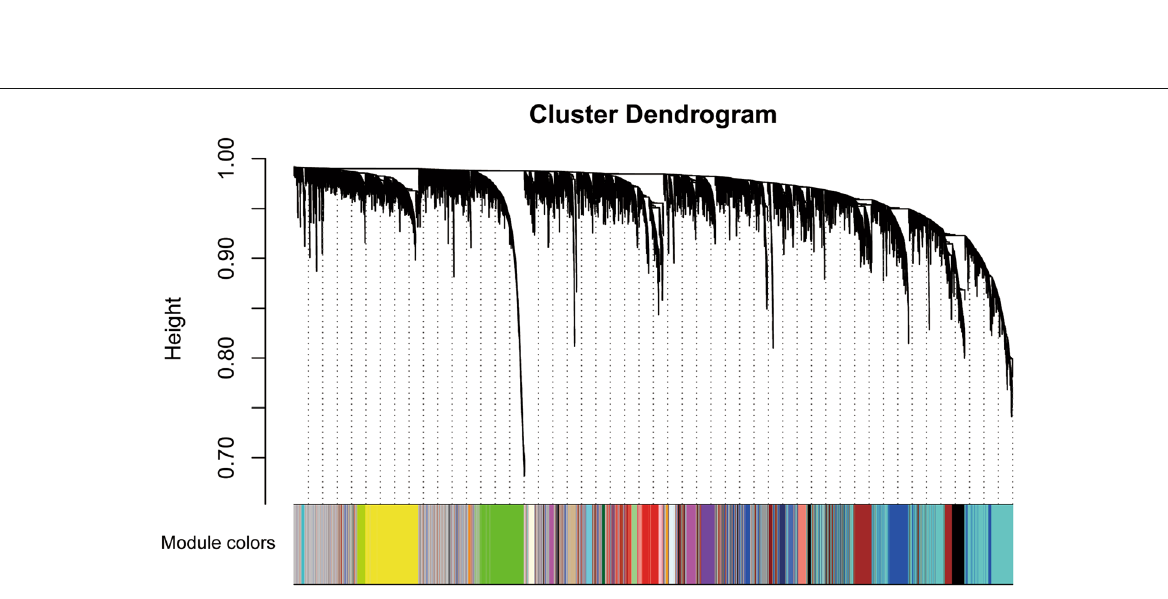
Fig. 3 The clustering dendrogram of genes in melanoma, every color below represents one co-expression gene